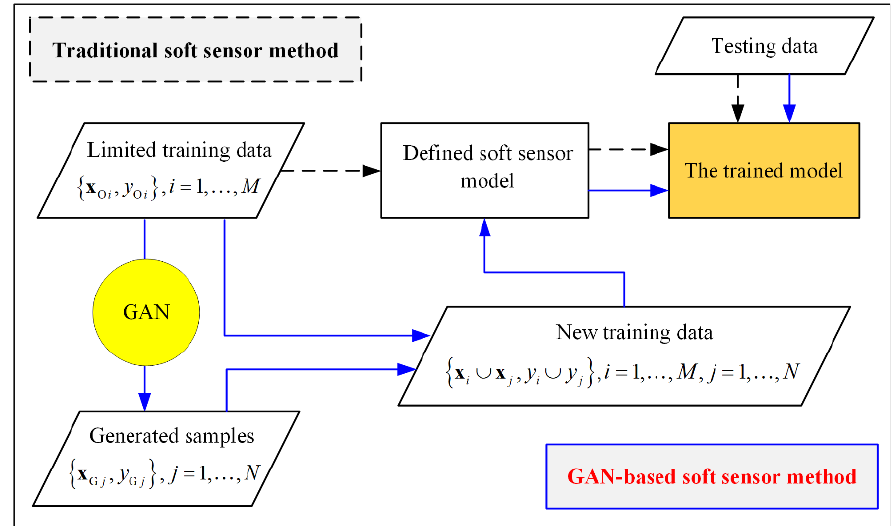
Figure 1. Flowchart of traditional and GAN-based soft sensor frameworks.